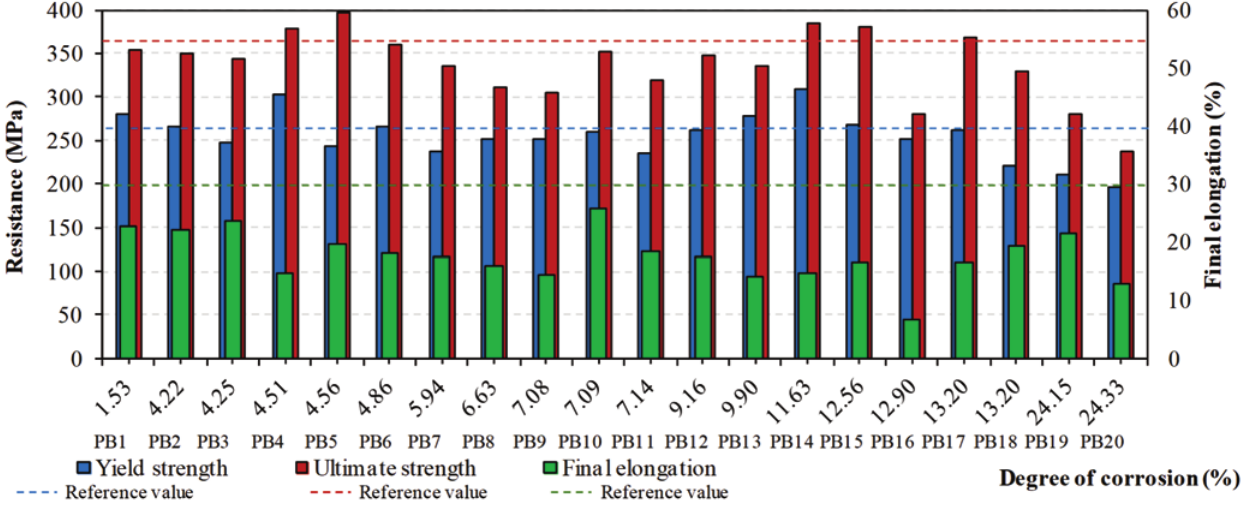
Ratio between degree of corrosion and yield strength, ultimate strength and final elongation of test specimens